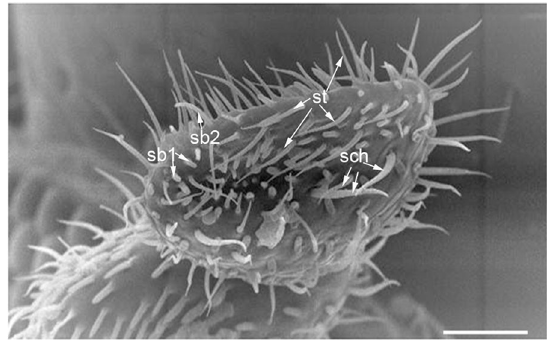
Fig. 4 Scanning electron micrograph (SEM) of a close-up view of the distal antennal flagellomere (Cl3) of adult Rhyzopertha dominica showing the most numerous sensilla; trichodea (st) and basiconica (sb1 and sb2) and sparsely distributed s. chaetica (sch) which were distinguished by its characteristic arch shaped shafts with longitudinal warts and emerging from a depressed cuticle.